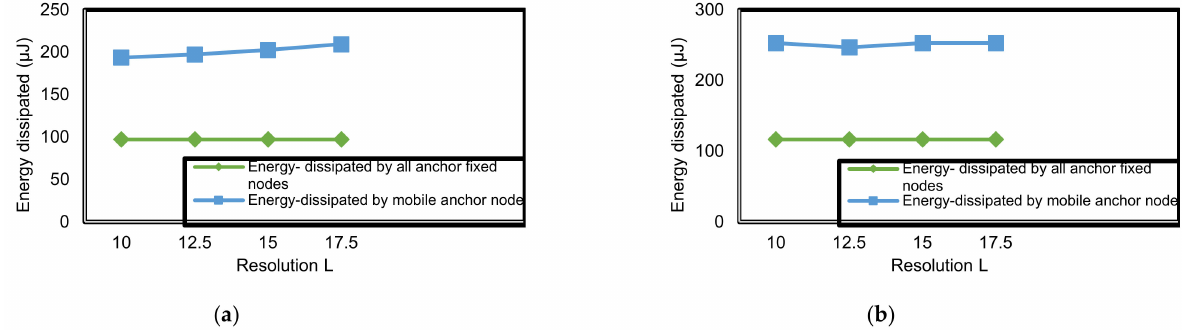
Figure 28. Energy dissipated ( µ J) corresponding to resolution (L) in both one mobile anchor node and fixed anchor nodes: ( a ) Arrow-Curve path model; ( b ) R-Curve path